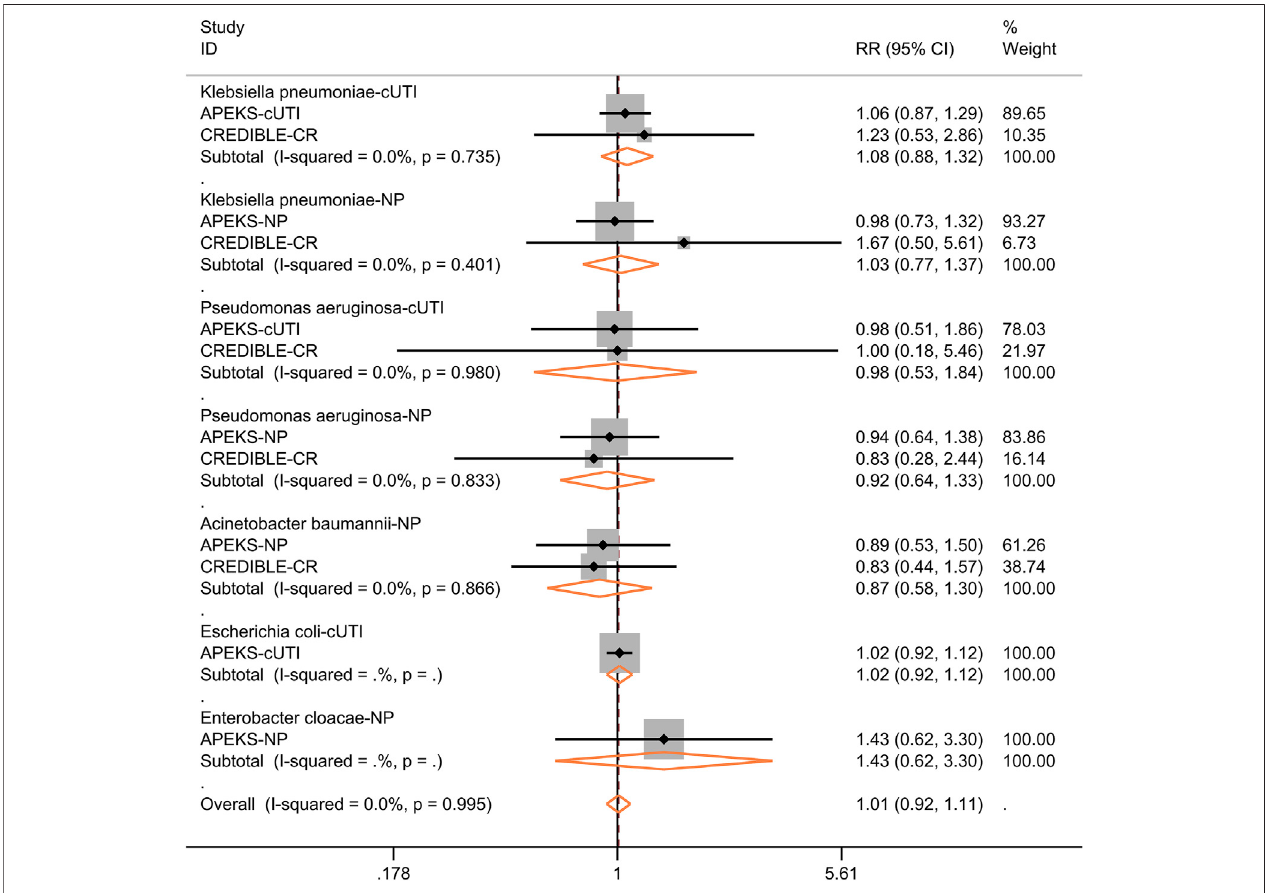
FIGURE 6 | Forest plot for the pooled analysis of clinical response at test of cure between ce fi derocol and comparators for the treatment of infections caused by speci fi c pathogens. Complicated urinary tract infection, cUTI; Nosocomial pneumonia, NP.